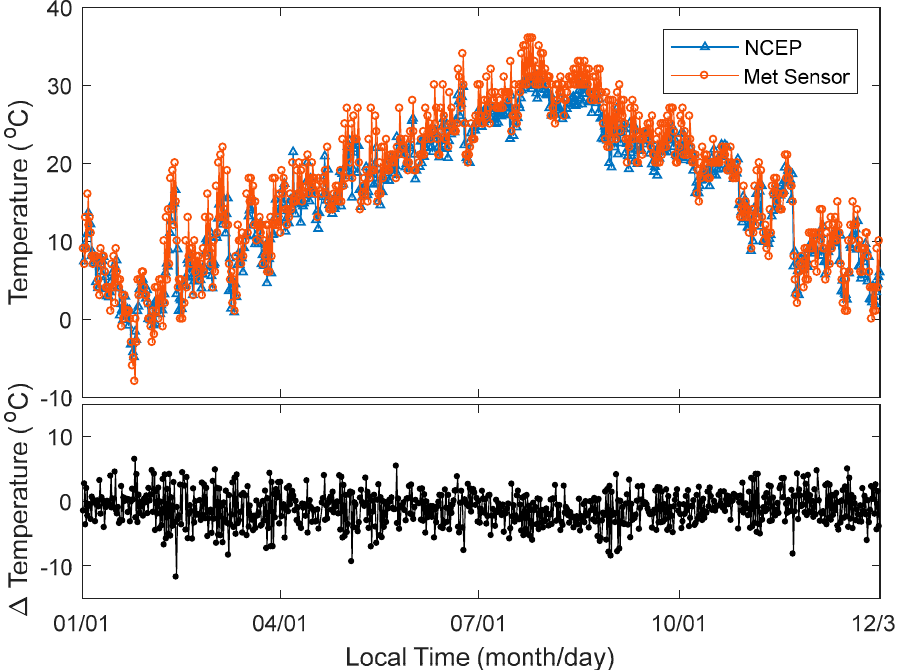
Figure A6. The temperature time series from NCEP and radiosonde at GPS Keqi station and HAZH radiosonde station, respectively.